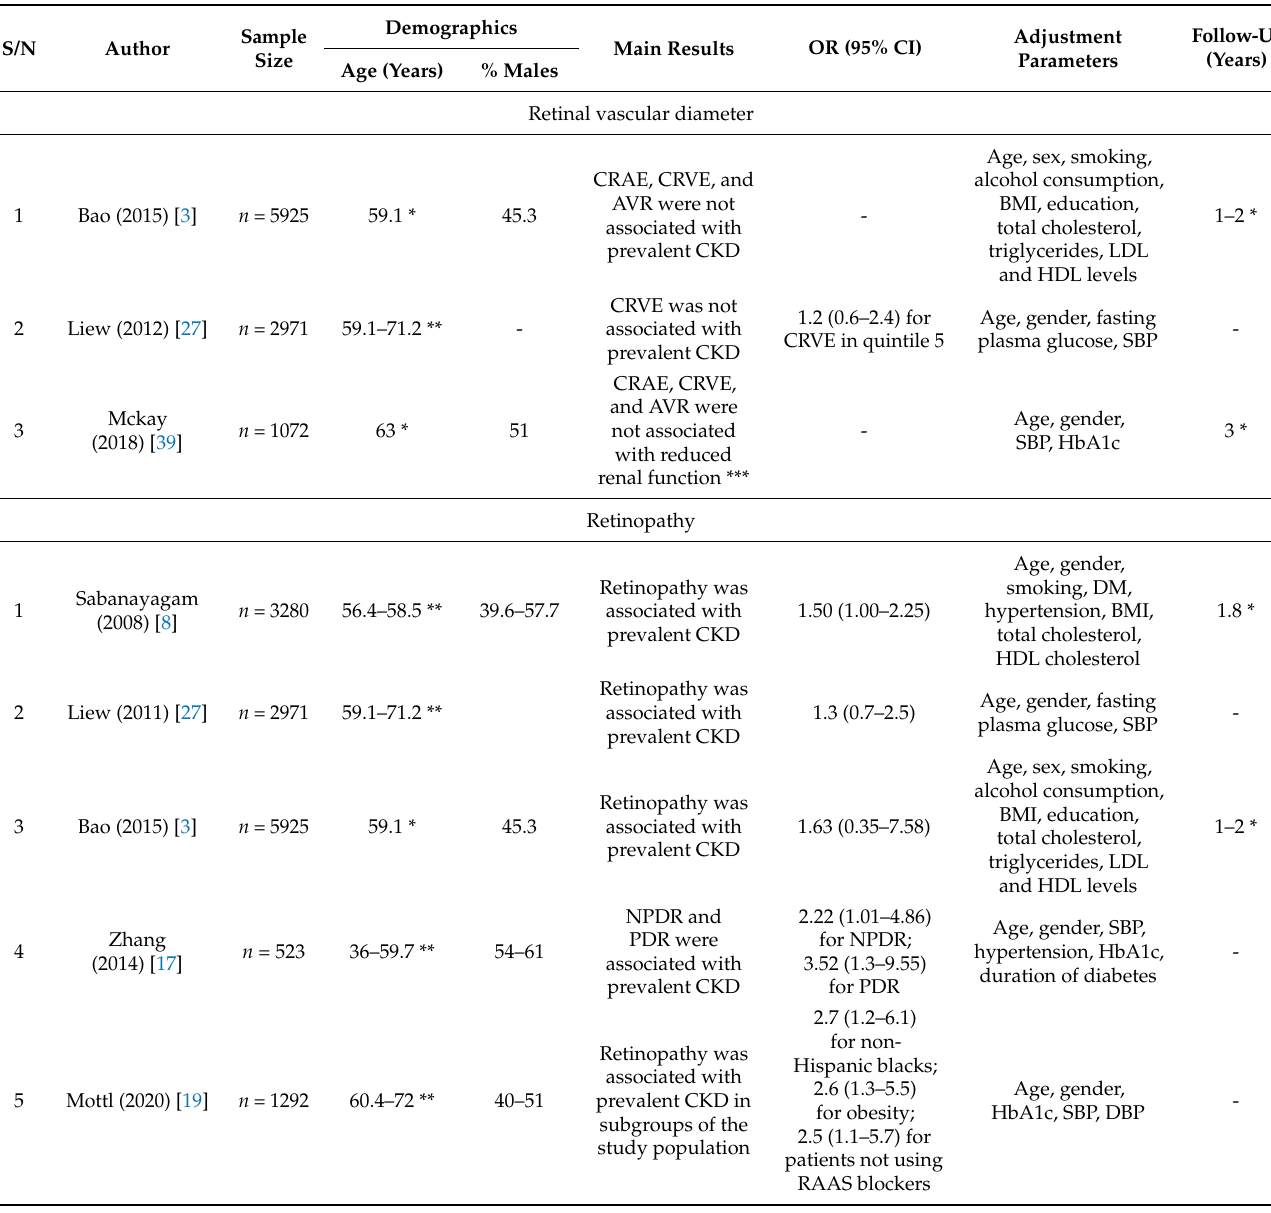
Table 8. Retinal microvascular signs and prevalent CKD in diabetic